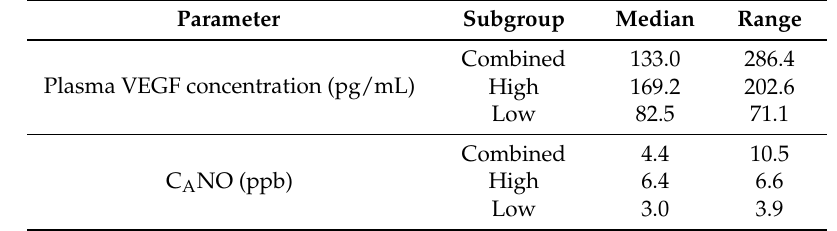
Table 2. Summary table of baseline plasma VEGF concentration and